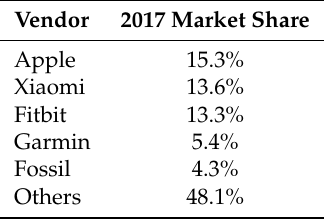
Table 1. Market share according to IDC Research Inc. [66].